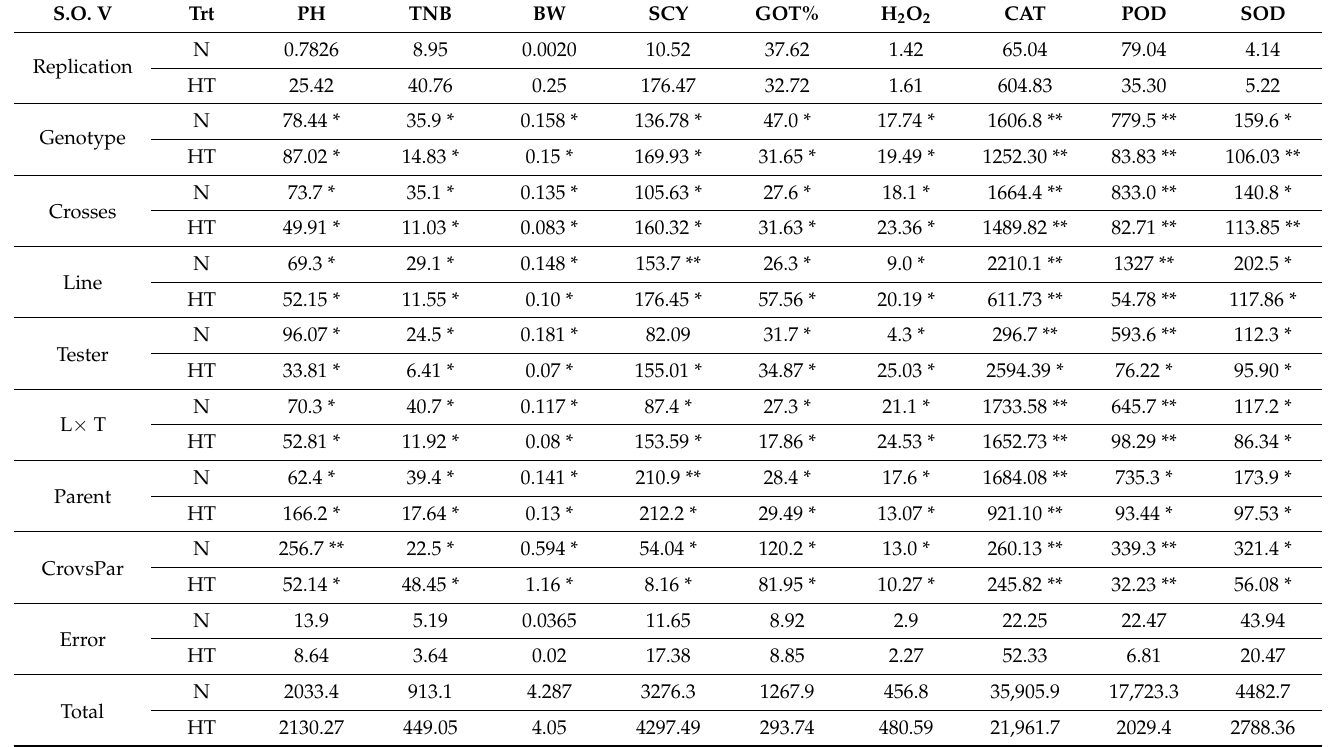
Table 4. First year mean squares of line × tester analysis for various characters under normal and high temperature stress